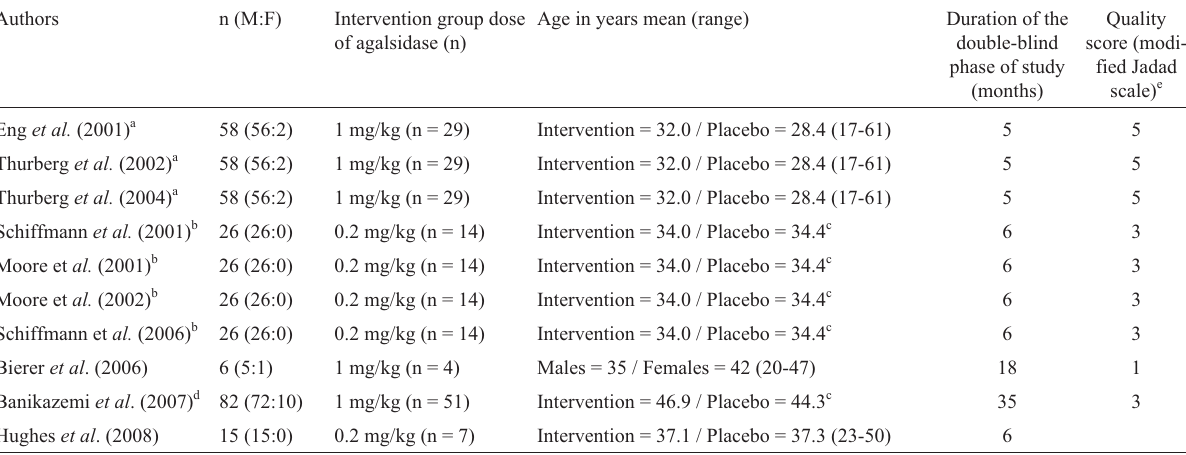
Table 1 - Overview of the double-blind, randomized, placebo-controlled trials of enzyme replacement therapy with agalsidase for Fabry disease.